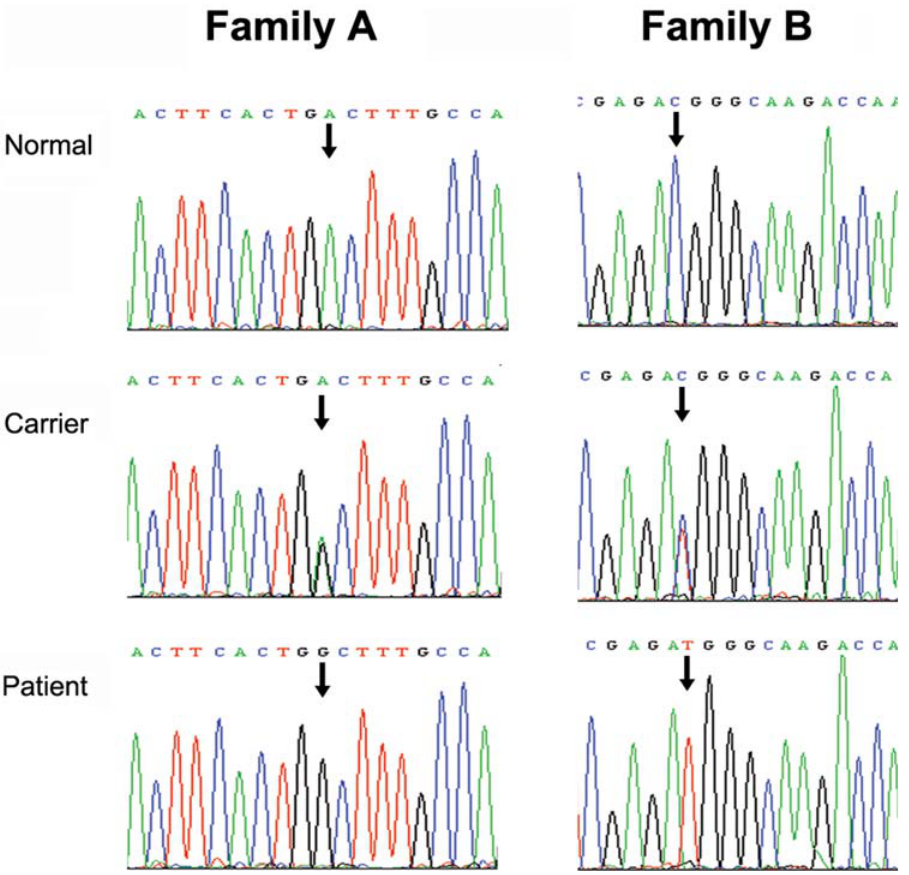
Figure 5. DNA sequencing chromatograms showing the mutations of affected members in Family A and Family B. In Family A, male patients show c.947A . G transition that is predicted to result in a p.D316G substitution in EDA and female carriers have A/G heterozygosity at the same position. In Family B, male patients show c.1013C . T transition that is predicted to result in a p.T338M substitution in EDA and female carriers are C/T heterozygous at the same position. Patient: male patients (hemizygous), carrier: female carriers (heterozygous), normal: normal individuals (no mutation).